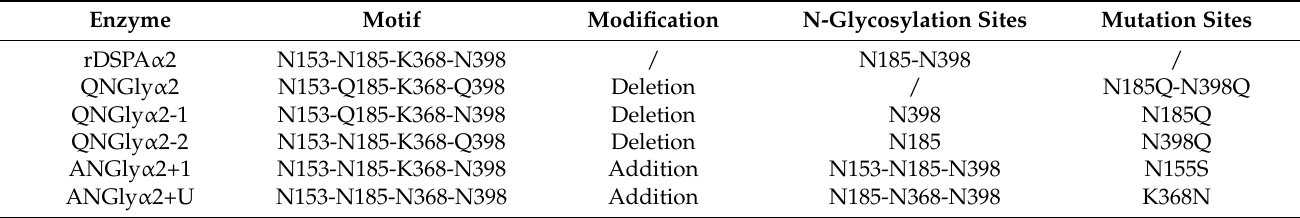
Table 1. N-glycosylation motifs of DSPA α 2 and its